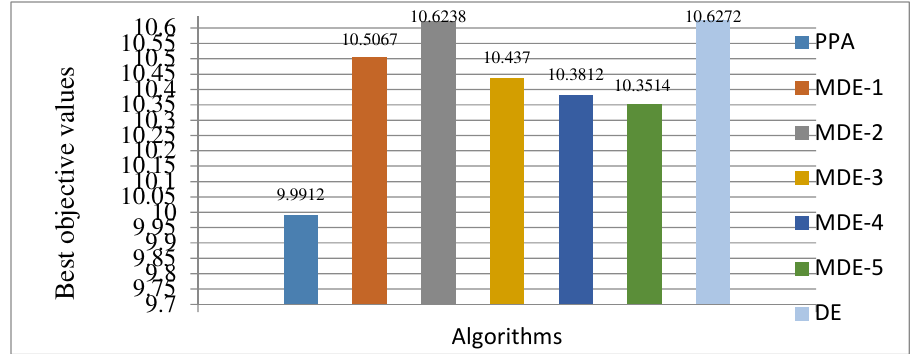
FIG. 8: BEST OBJECTIVE VALUES OBTAINED BY PPA ARE COMPARED WITH DE AND ITS VARIANTS IN SOLVING THE 6-BUS PROBLEM OF DOCRS.